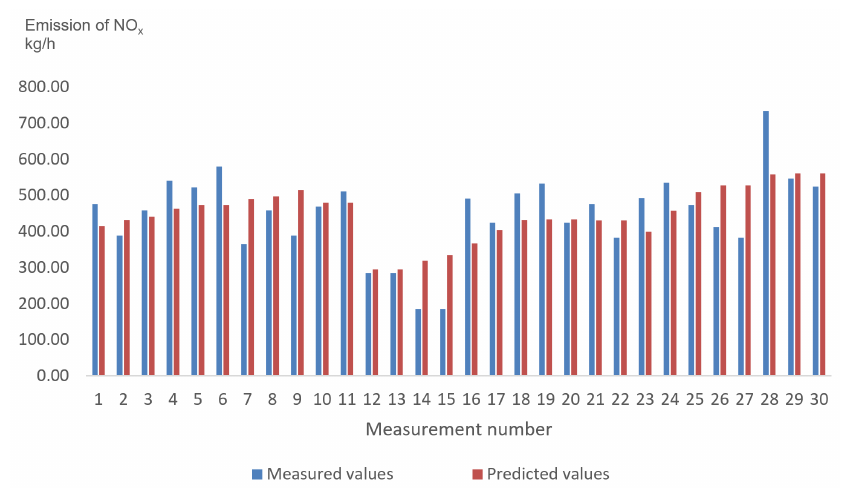
Figure 4. Comparison of the predicted values of the NO x emission model with measured values.